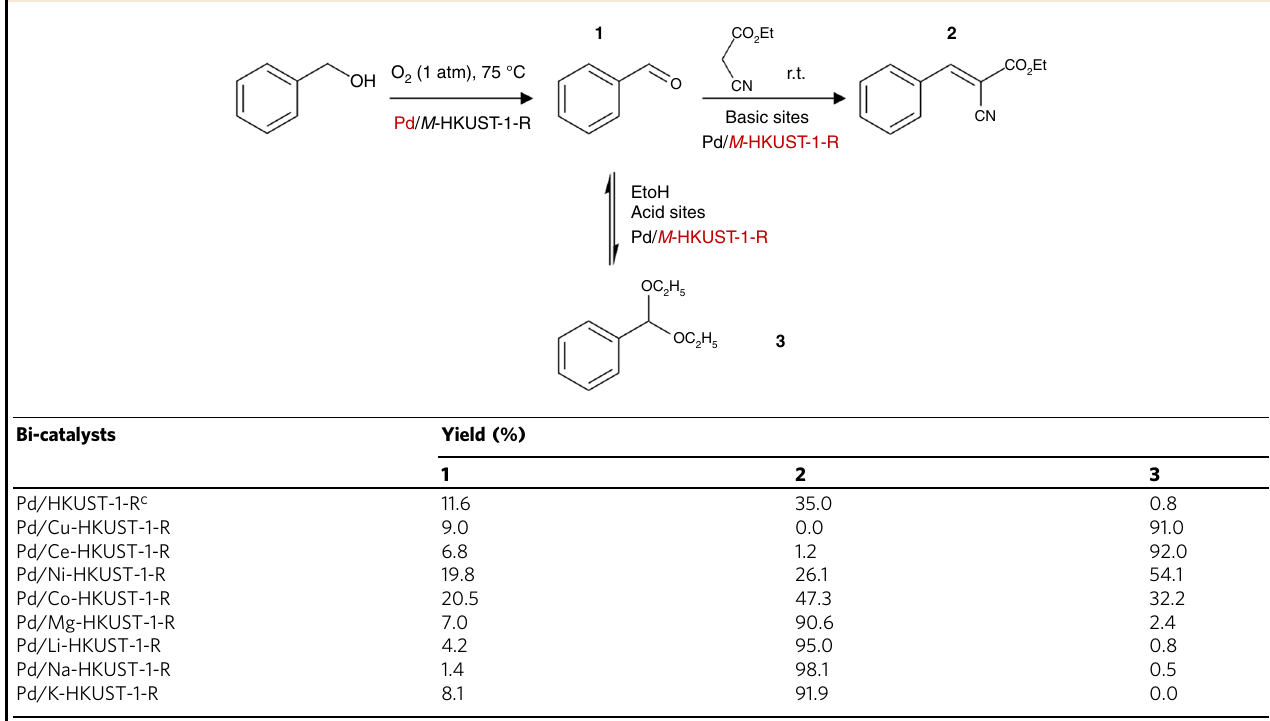
Table 1 Pd/ M -HKUST-1-R catalysed stepwise oxidation a – Knoevenagel condensation b